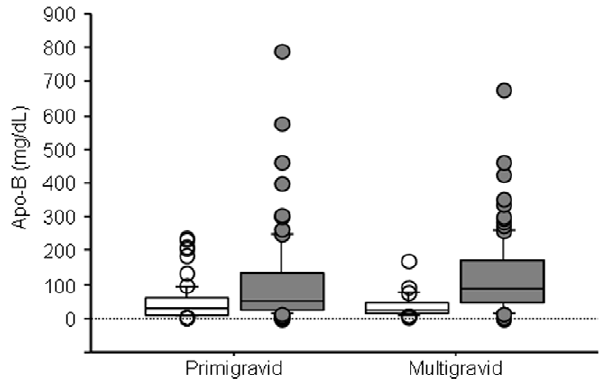
Figure 3. Comparison of peripheral plasma levels of Apo-B between malaria-infected primigravid and multigravid wom- en. Apo-B in malaria-infected (open boxes) and uninfected (gray boxes) women stratified by gravidity. Numbers of samples tested (infected, uninfected) and the significance of the differences between malaria- infected and uninfected women (P value analyzed by Mann-Whitney U test): primigravid (75, 75; p =0.0008; multigravid (33, 112; p = , .0001). The box plots include the median (middle line), interquartile ranges (box), and 10–90 th percentiles (whiskers).